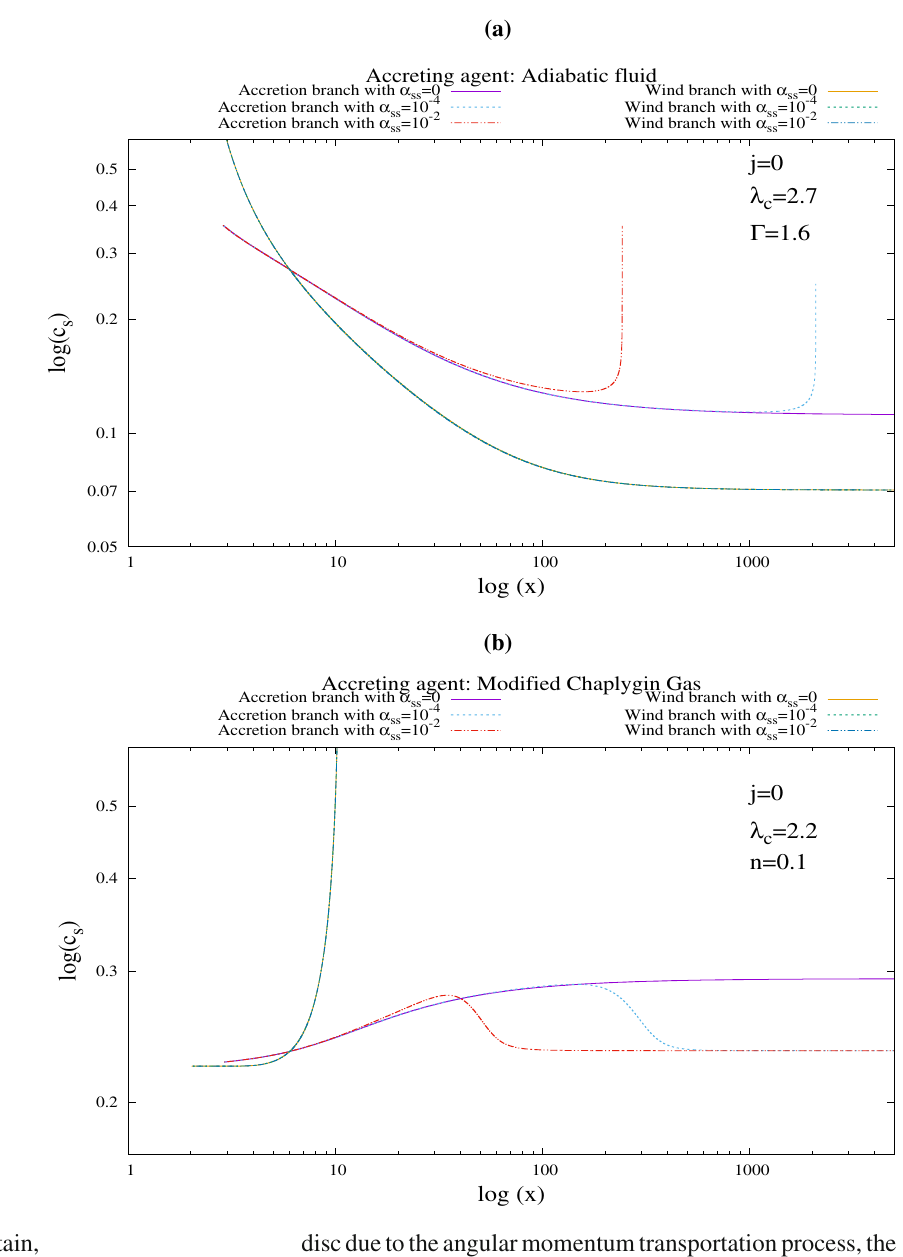
Fig. 1 Plots of accretion and wind branches for log ( c s ) (log of sound speed) vs log ( x ) for non-rotating black hole with different viscosity parameter (showed in different colours). a For adiabatic fluid accretion.